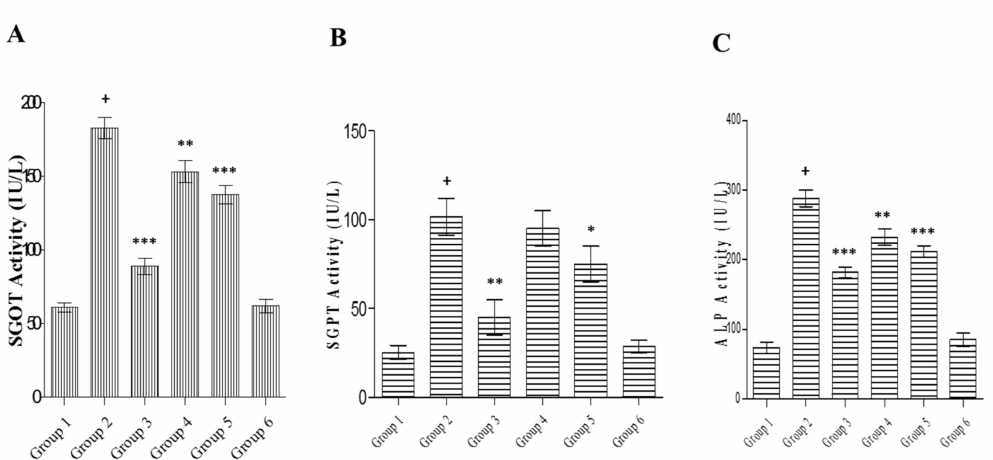
Figure 8. E ff ect of C. lanceolatus methanolic extract on serum glutamate oxaloacetate transaminase (SGOT) ( A ), glutamate pyruvate transaminase (SGPT) ( B ) and alkaline phosphatase (ALP) ( C )